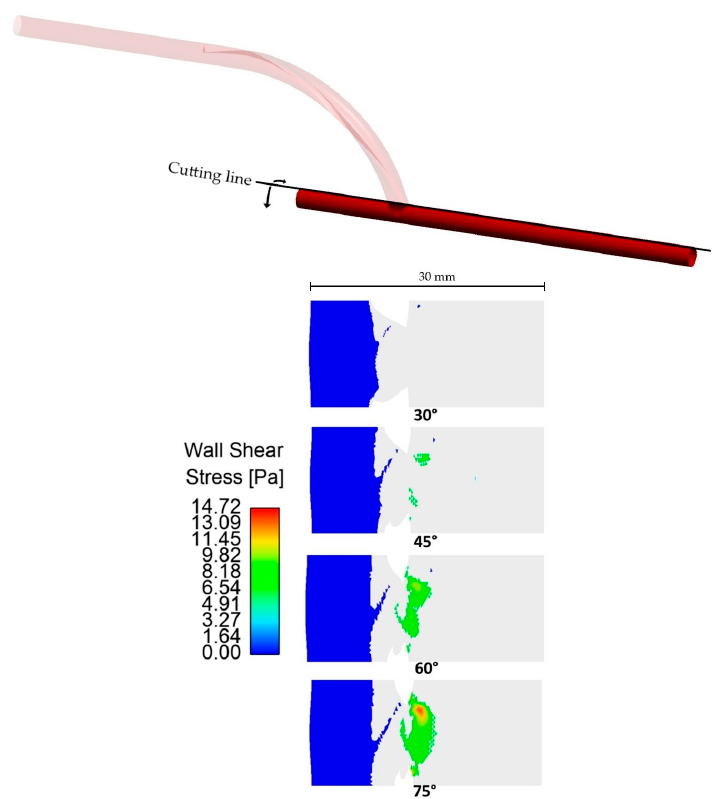
Figure 9. Areas on the host artery (unrolled) affected by abnormal WSS. Only pertinent regions where abnormal WSS was observed were shown instead of the whole arterial length.